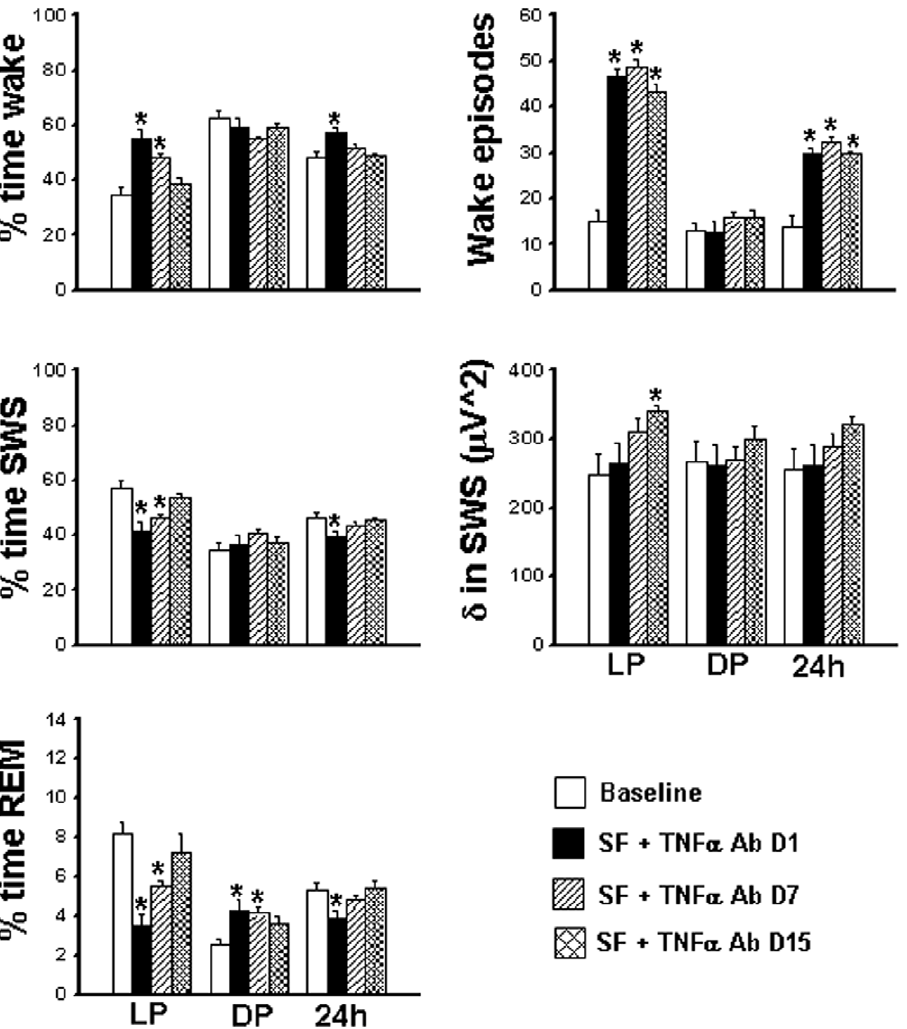
Figure 6. Sleep-wakefulness, EEG delta power in SWS and wake episodes (light period, dark period and total (24 h) in TNF- a antibody injection mice. Comparison of sleep parameters in TNF- a antibody injection mice during light (LP), dark (DP) and 24 hours (24 h) period at baseline (open bar), day 1 (filled bar), day 7 (hatched bar) and day 15 (double hatched bar) following SF LP, light period; DP, dark period. *p , 0.05. *=comparison between baseline and SF during respective post-fragmented days.